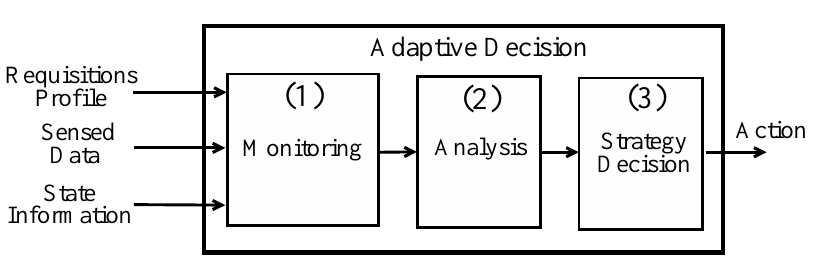
Figure 1. Adaptive